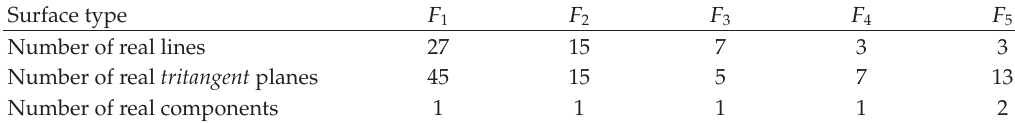
Table 1: Some geometric information of nonsingular cubic surfaces (cid:2) derived from (cid:7) 14 (cid:8)(cid:3) . Surface